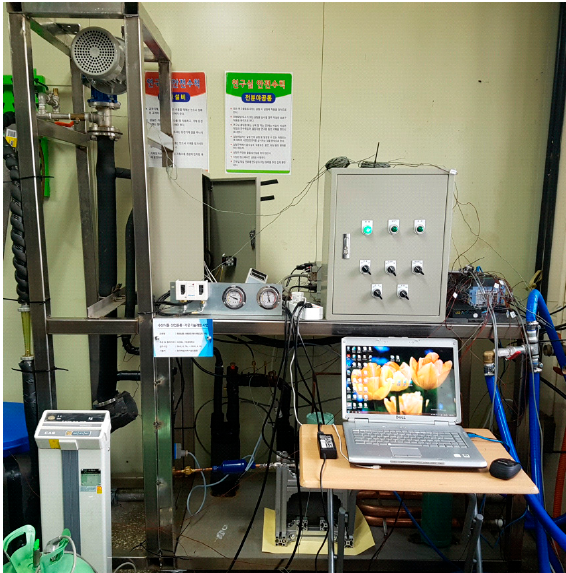
Figure 3. Photograph of an experiment apparatus.